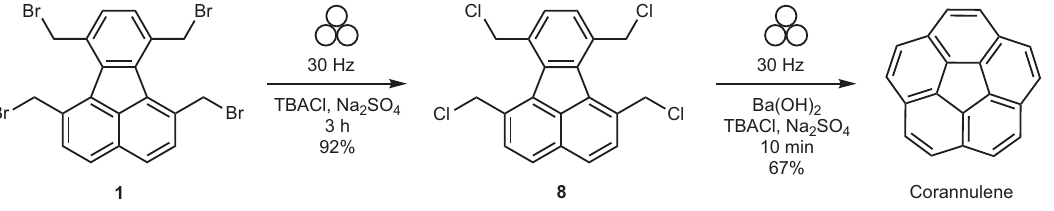
Fig. 6 A new synthetic route to corannulene. Synthesis of corannulene from tetrachloromethyl fl uoranthene precursor 8